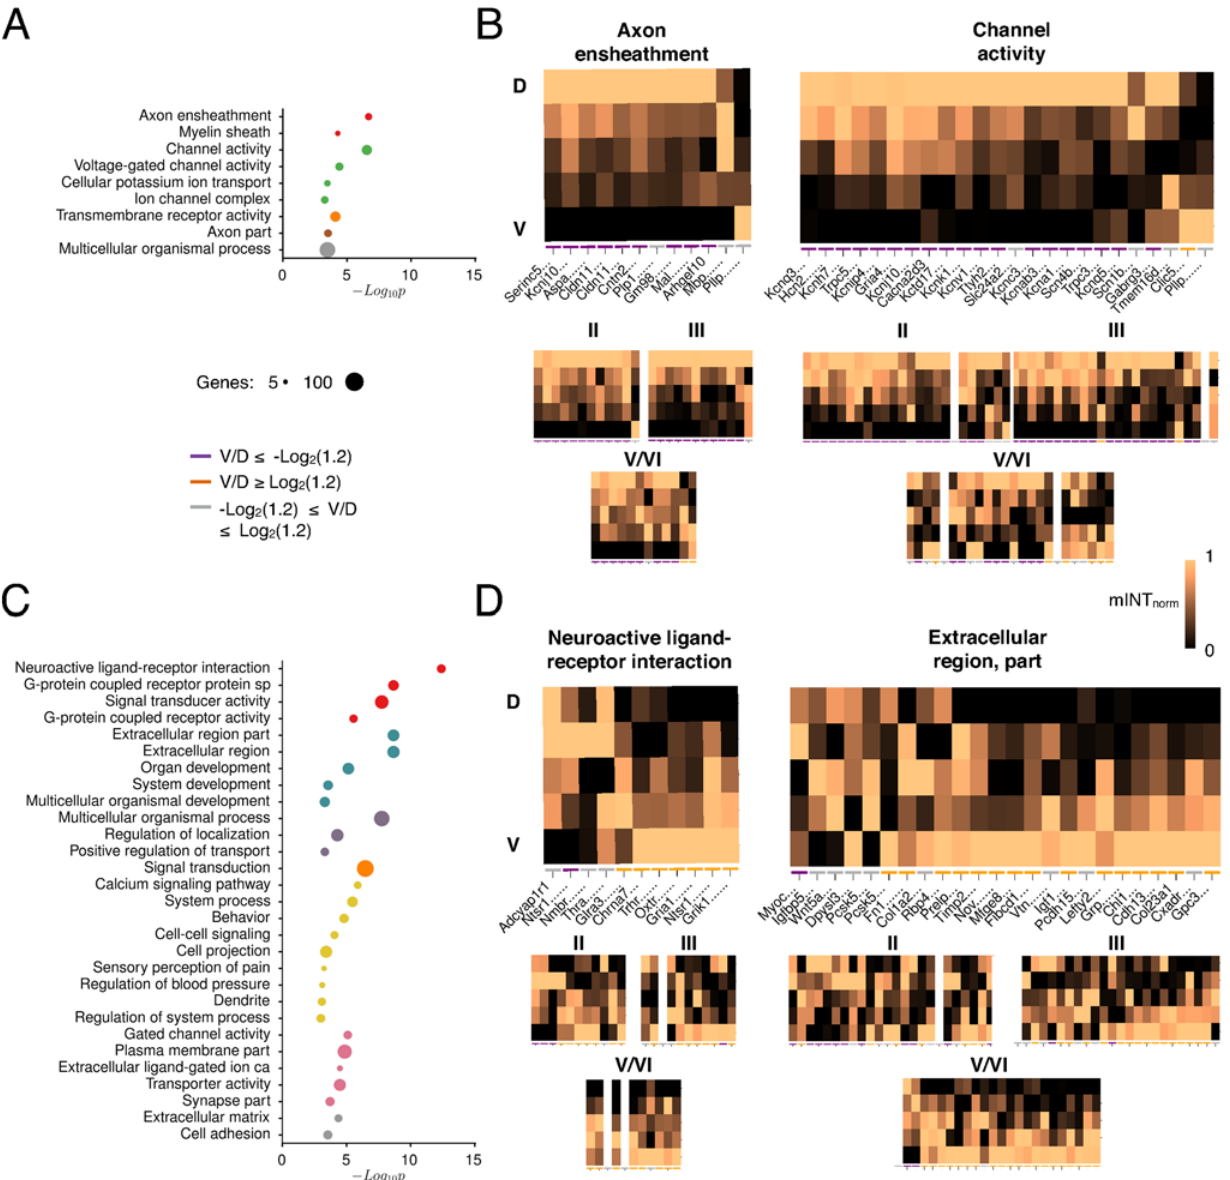
Figure 8. Functional grouping of genes with dorsoventral organization. (A, C) Overrepresented non-redundant GO terms for genes identified as being expressed at significantly higher levels in (A) dorsal (D > V) and (C) ventral (V > D) regions using Cuffdiff 2 analysis of RNA-Seq data [58]. Terms were clustered based on kappa similarity [103]. Only the most significant terms p < 0.001 from each cluster that are sufficiently different from each other (kappa score < 0.7) are shown. (B, D) Genes of functional interest show corresponding patterns of (B) D > V and (D) V > D expression in ABA data. Heat plots indicate the normalized mean pixel intensity (mINT norm ) for a gene across all MEC layers as a function of dorsoventral position. Normalization was performed by setting all values to the range [0, 1]. All RNA-Seq defined D > V and V > D genes with mINT MEC (cid:1) 2 in the re-registered data set are included. Colored bars beneath heat plots indicate whether the difference between dorsal and ventral regions was at least 20% (see legend). Plots also shown for individual layers (see S4 Fig.); data not shown for those with mINT [layer] < 2. Where ISH was performed with multiple probes for one gene, data from both are shown. SP: signaling